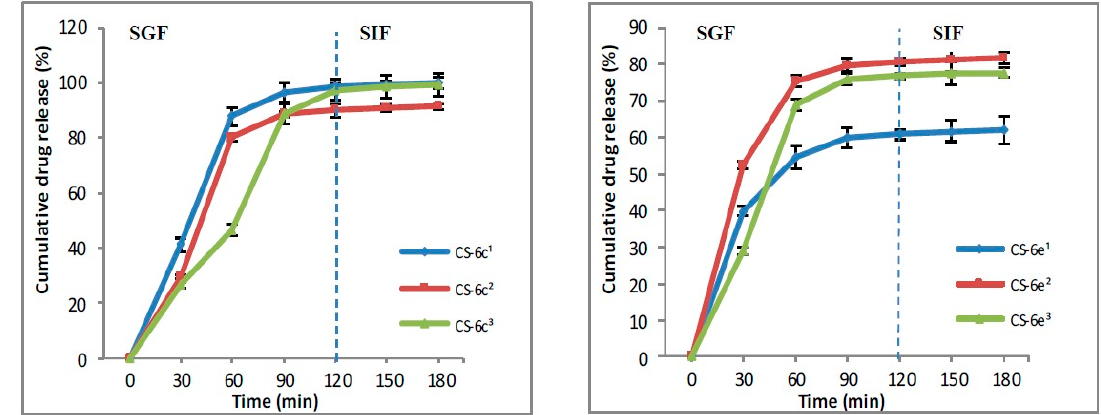
Figure 9. The release profile of compound 6c and 6e from CS-6c and CS-6e respectively ( 1 = 3 mg/mL, 2 = 4 mg/mL, 3 = 5 mg/mL).